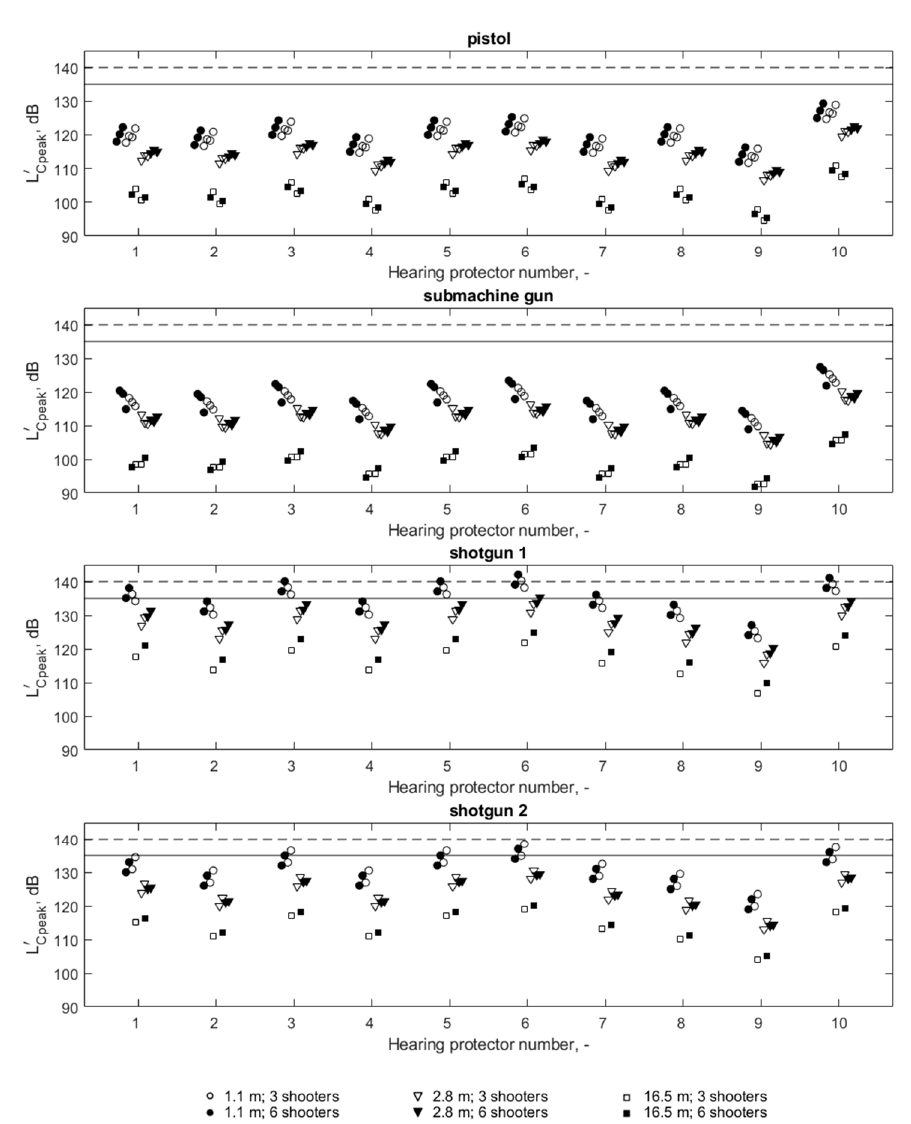
Figure 8. L Cpeak values (under hearing protectors) for four weapon/ammunition combinations. The horizontal continuous line indicates the criterion value of 135 dB, while the dotted line represents a criterion value of 140 dB.